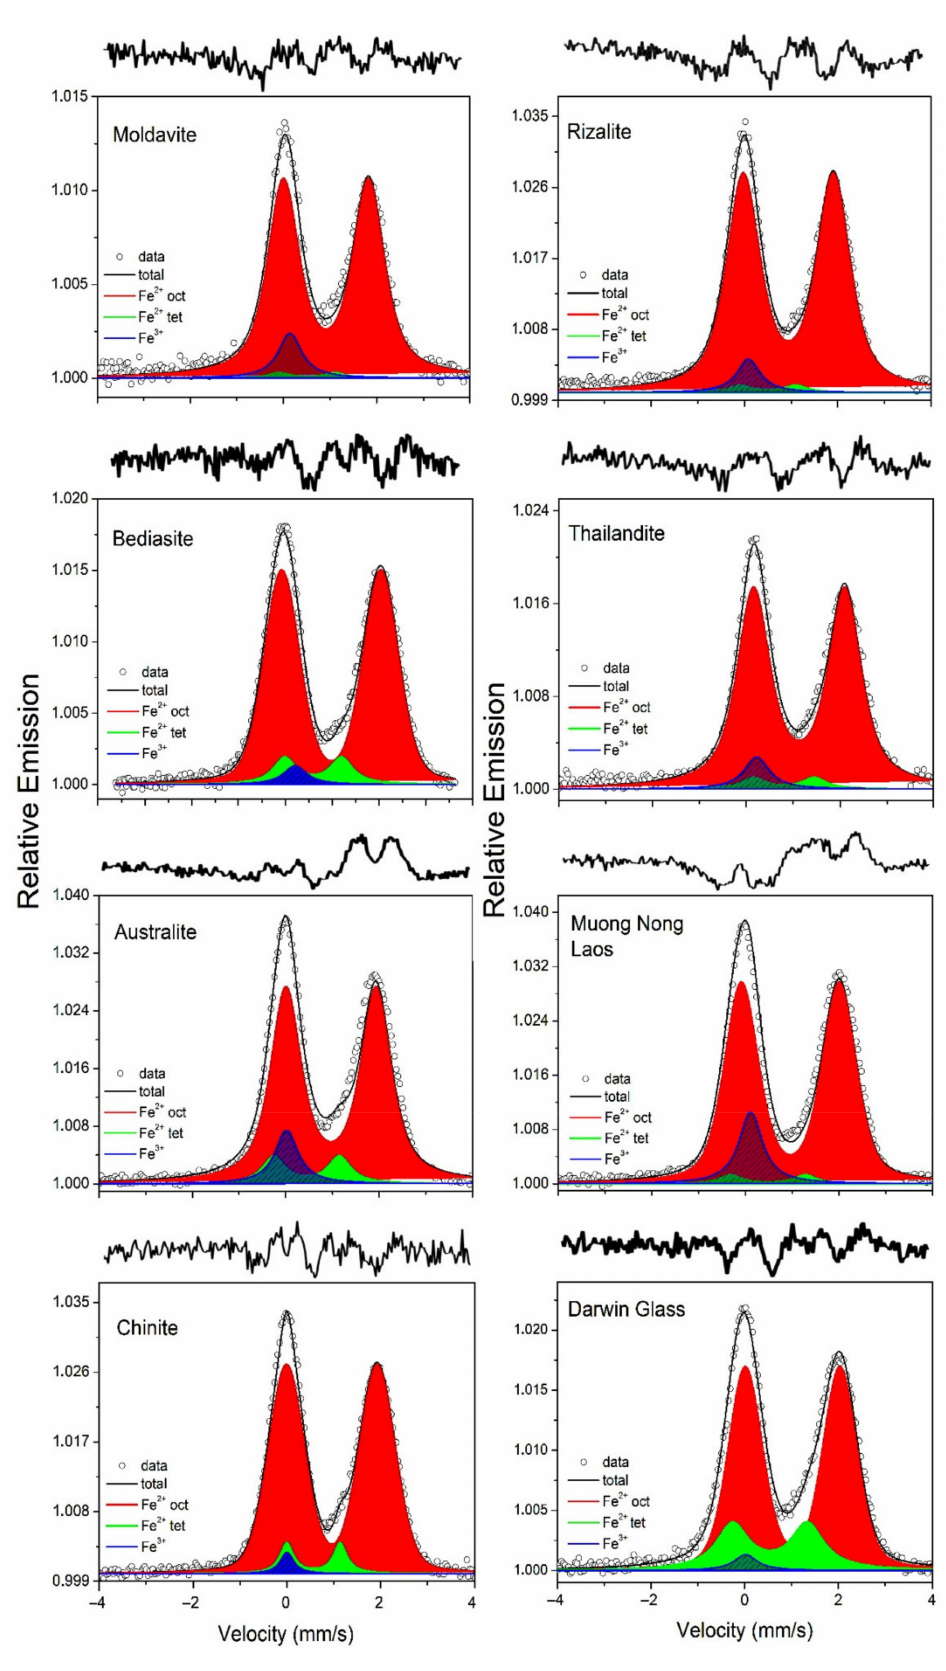
Figure 20. Representative 57 Fe Mössbauer spectra taken at RT in backscattering geometry of typical